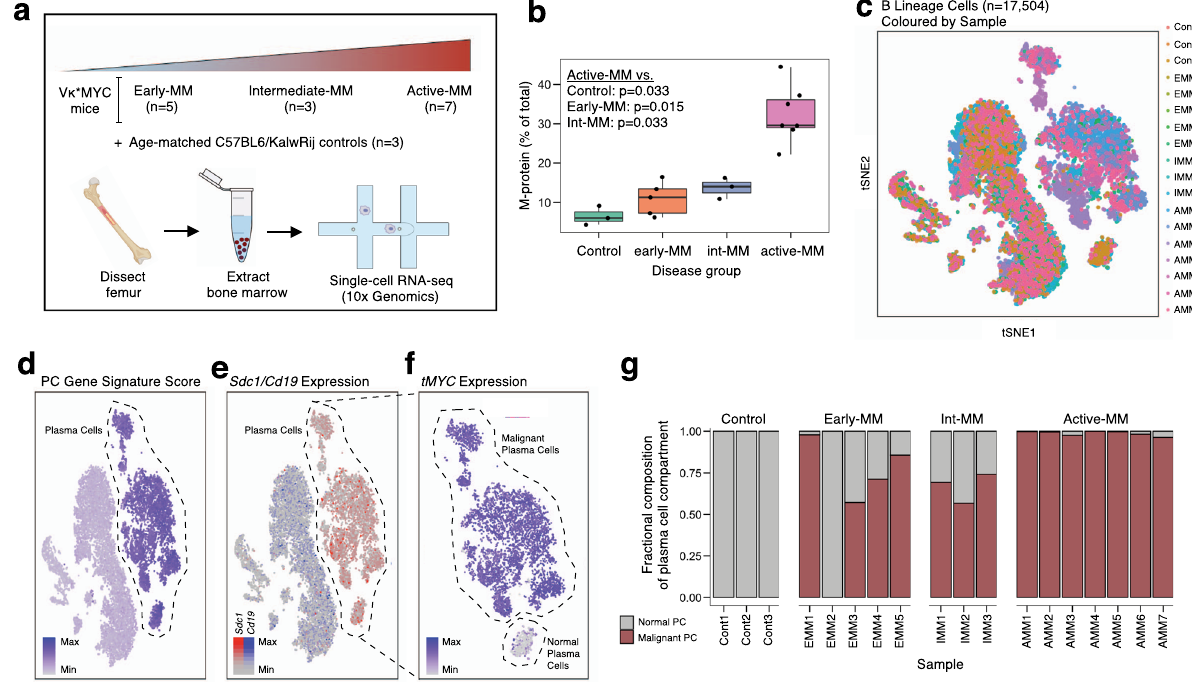
Fig. 1 A single-cell transcriptional map of malignant cells from progressing V κ *MYC mice. a Schematic of V κ *MYC mouse cohort and experimental work fl ow for collection of single cells. Graphics created in part using BioRender.com. b Disease burden across cohort as determined by M-protein measurements from SPEP. Statistical comparison of multiple groups was performed using a Wilcoxon rank-sum test (two-sided) corrected for multiple testing (Benjamini − Hochberg). Boxplots represent the distribution of each measurement within de fi ned groups, where the central rectangle spans the interquartile range, the central line represents the median, and “ whiskers ” above and below the box show the value 1.5× the interquartile range. Only P values for statistically signi fi cant comparisons are listed. Data points represent measurements from biologically-independent animals (Control ( n = 3), early-MM ( n = 5), int-MM ( n = 3), and active-MM ( n = 7)). c tSNE visualization of 17,504 B lineage cells, coloured by sample ID. d tSNE visualization of B lineage cells, coloured by plasma cell gene signature score (Hay SB et al. 28 ). e tSNE visualization of B lineage cells, coloured by the relative expression of indicated cell-type-speci fi c genes. f tSNE visualization of plasma cells identi fi ed by criteria displayed in ( d ) and ( e ) coloured by the relative expression of V κ *MYC transgene ( tMYC ). g Bar plot showing the distribution of normal vs. malignant plasma cells across samples No malignant cells were detected in EMM2 and thus it was removed from downstream malignant cell analyses. Source data are provided in SourceData_Fig. 1.xlsx. EMM: early-MM, IMM: intermediate-MM, AMM: